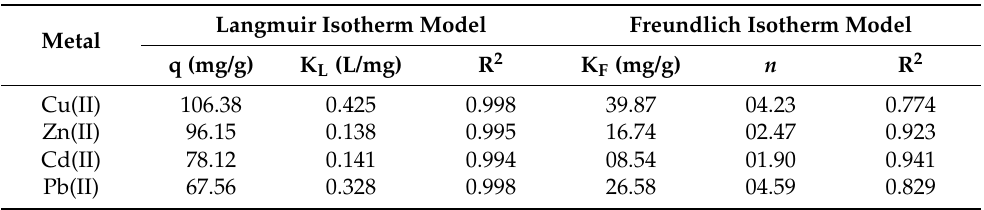
Table 3. Adsorption isotherm parameters for the removal of heavy metals onto SiNTh-Py (shaking